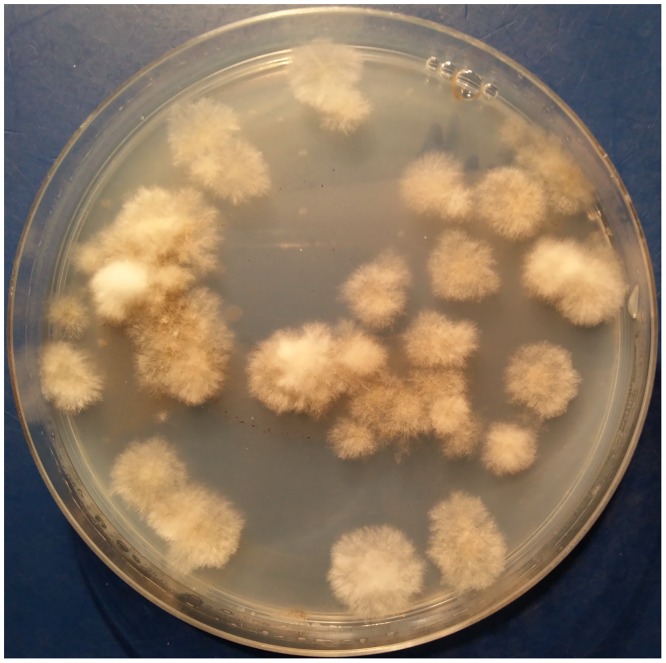
Colonies of Scedosporium on Scedo-Select III agar after inoculation of 100 μl of soil suspension from each sample and incubation at 35°C for 5 days.